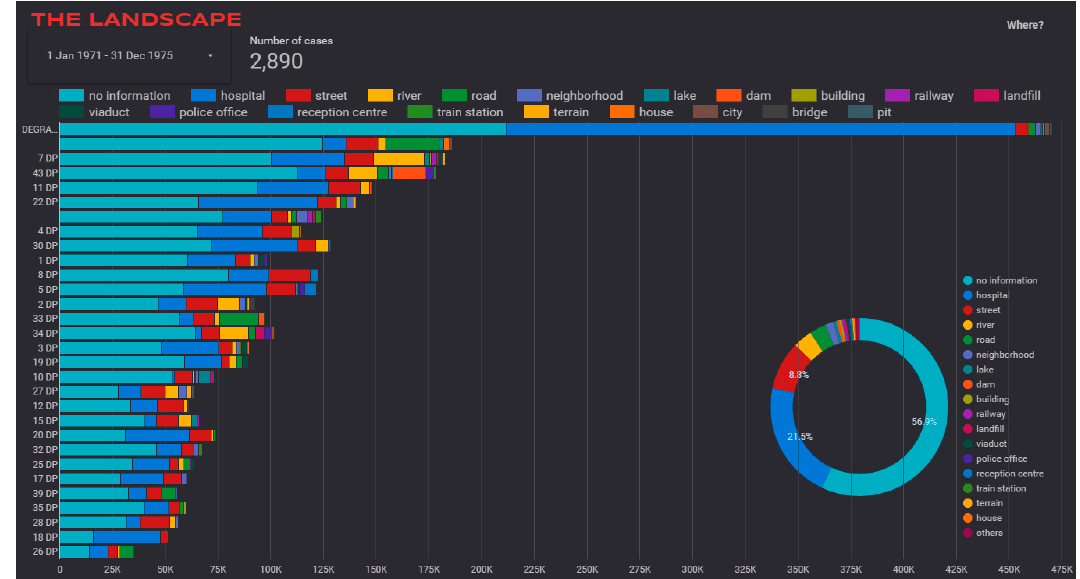
Figure 8. Google Data Studio dashboard about locations, created as a prototype to visualize NLP results.